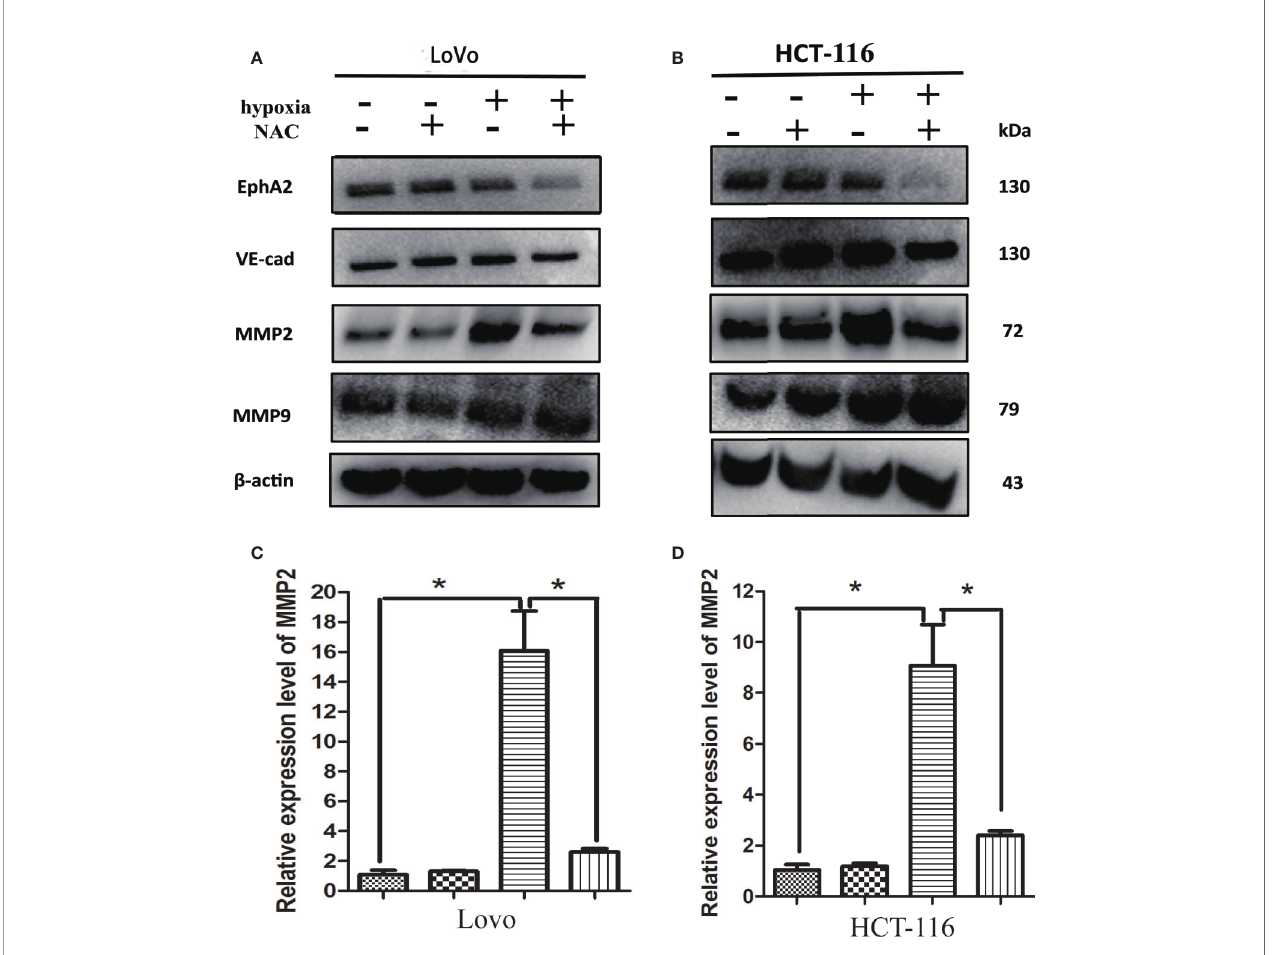
FIGURE 6 | Up-regulation of MMP2 under hypoxia requires ROS generation. (A, B) The expressions of EphA2, VE-cad, MMP2, MMP9 using western blotting analysis after the indicated treatment. Results showed that NAC markedly blocked hypoxia-stimulated MMP2 expression compared with the untreated group; (C, D) The expressions of MMP2 using RT-PCR after the indicated treatment (* P <